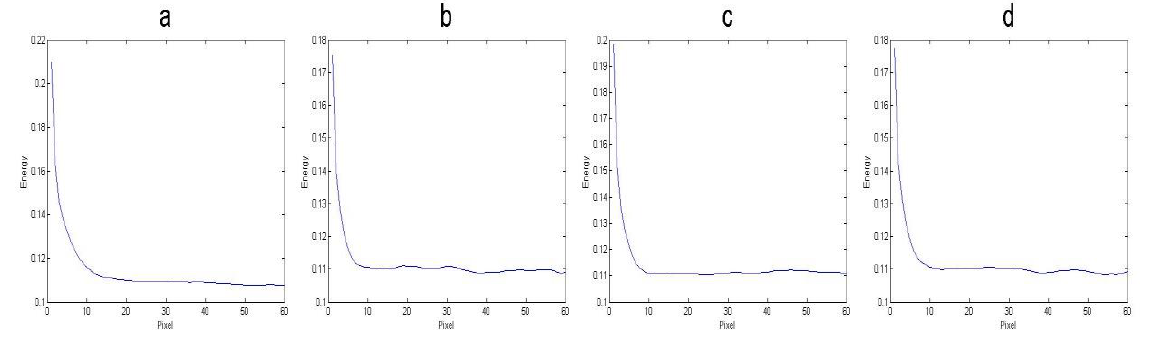
Fig. 11: Co-occurrence energy feature curves of the surface specimen with R